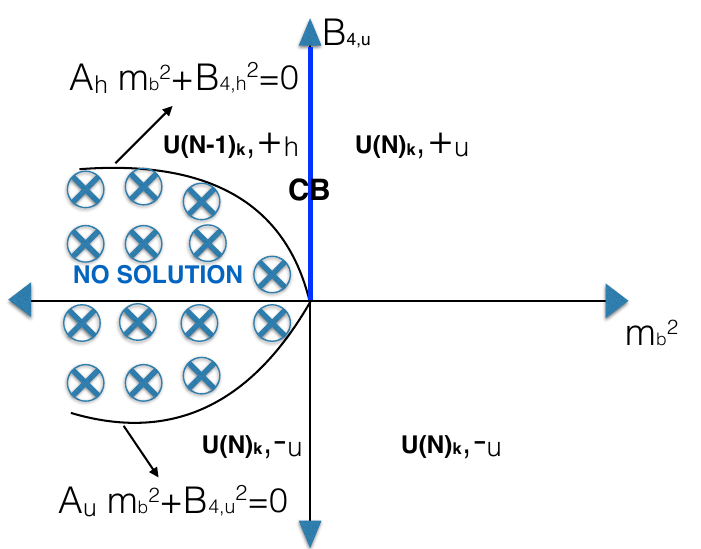
Figure 9. The phase diagram for x 6 < (cid:30) 1 . For B 4 ;u > 0 we have a second order phase transition at m 2 = 0 between + u and + h phases, while for B 4 ;u < 0 the b exists. There are no solutions for small enough values of m 2 blue crosses in the